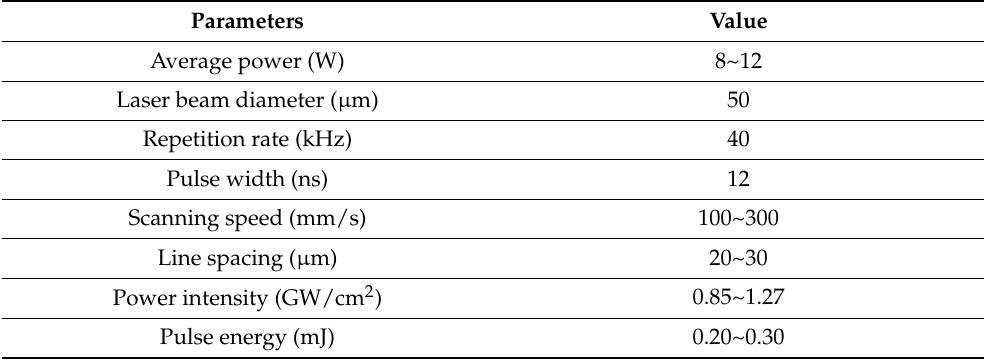
Figure 1. Process schematic for laser-heat surface treatment. Reprinted with permission from ref. [36]. Table 1. Laser processing parameters for laser-heat surface treatment.